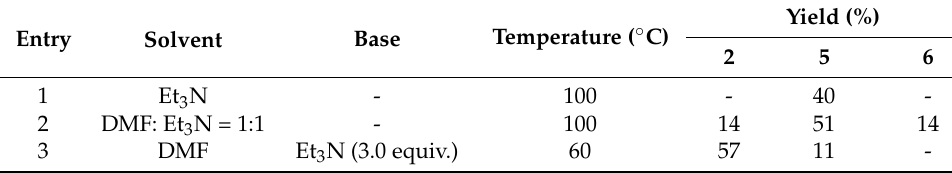
Scheme 2. Synthesis of PPAR γ ligand. Table 1. Investigation of PPAR γ ligand synthesis